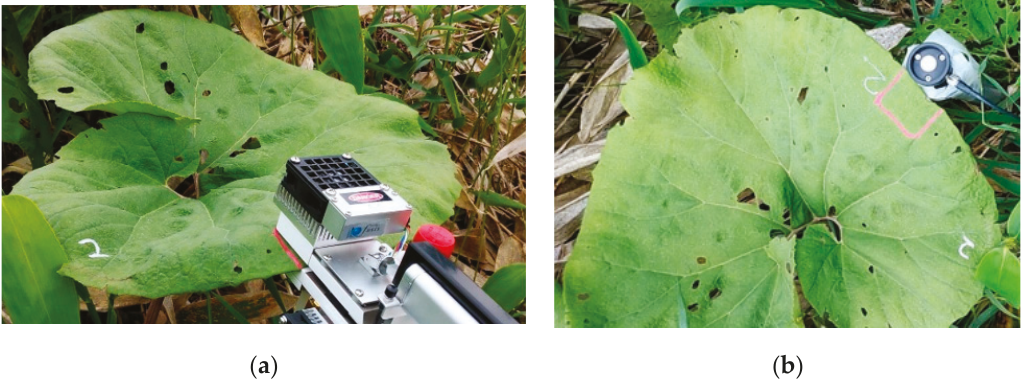
Figure 3. Measurements of ( a ) photosynthesis and ( b ) the diurnal course of incident light in the clearing site. The two panels show the same leaf. The position on the leaf lamina, at which photosynthetic traits and incident light were measured, was marked with a light-resistant ink pen (red box). In the cases when that part of the lamina was inclined, the light sensor was inclined such that the lamina and the top of the sensor were parallel to one another. Leaf mass per area (LMA) was subsequently measured by sampling the lamina part within the same red box. Photographs were taken on ( a ) June 21 and ( b